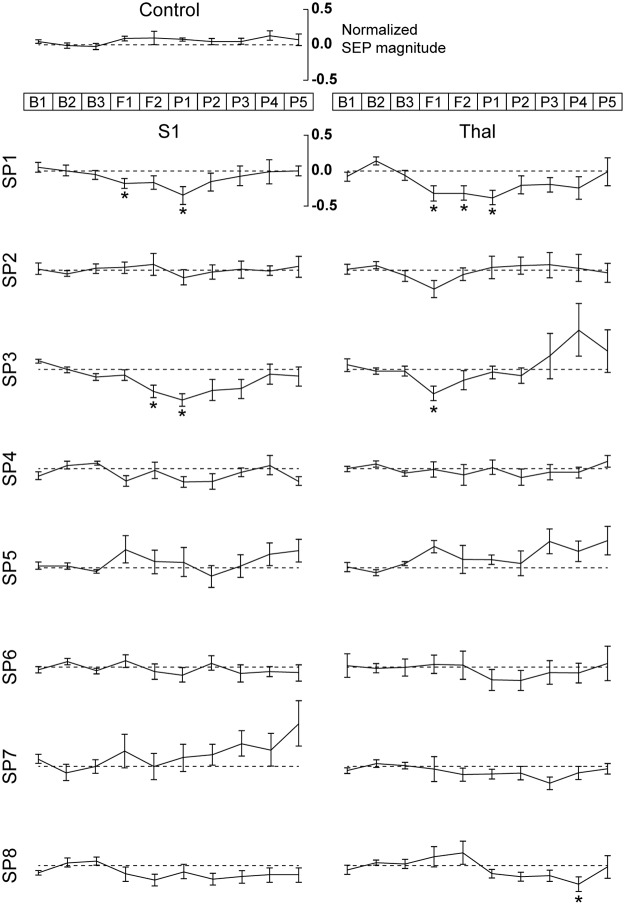
Normalized SEP magnitude (P50 –N40; averaged across the animals shown with standard error) before (B1–B3), during (F1, F2), and after (P1–P5) sonication of the contralateral S1 (left column) and thalamus (right column).The top shows the data acquired from the control condition (i.e., sonication of the ipsilateral S1 and thalamus), with each row representing the data acquired with each sonication parameter set (SP1–SP8; refer to Table 2 for detailed parameters). The dashed line indicates the normalized signal level averaged across baseline B1–B3 segments (set to zero). The asterisks indicate statistically significant differences (one-tailed t-test, p < 0.01) in SEP magnitude when compared to the control condition.